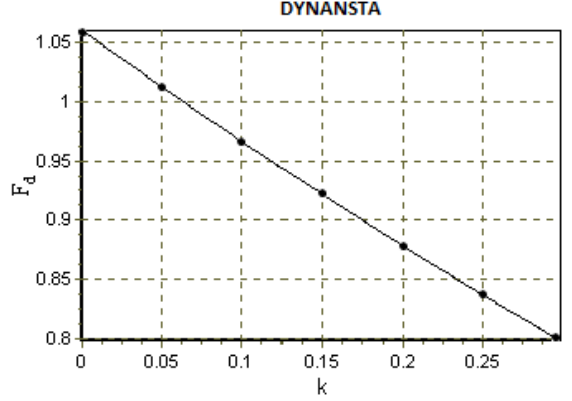
Figure 4: Effect of the internal friction angle with PLAXIS and GEOSTAB.